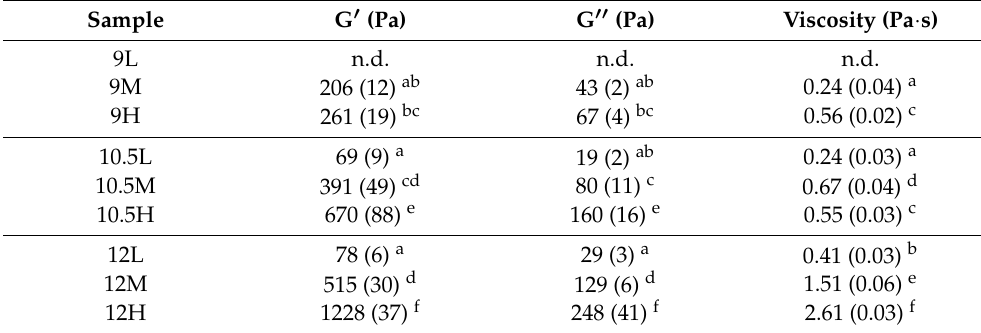
Table 1. Rheological parameters of the